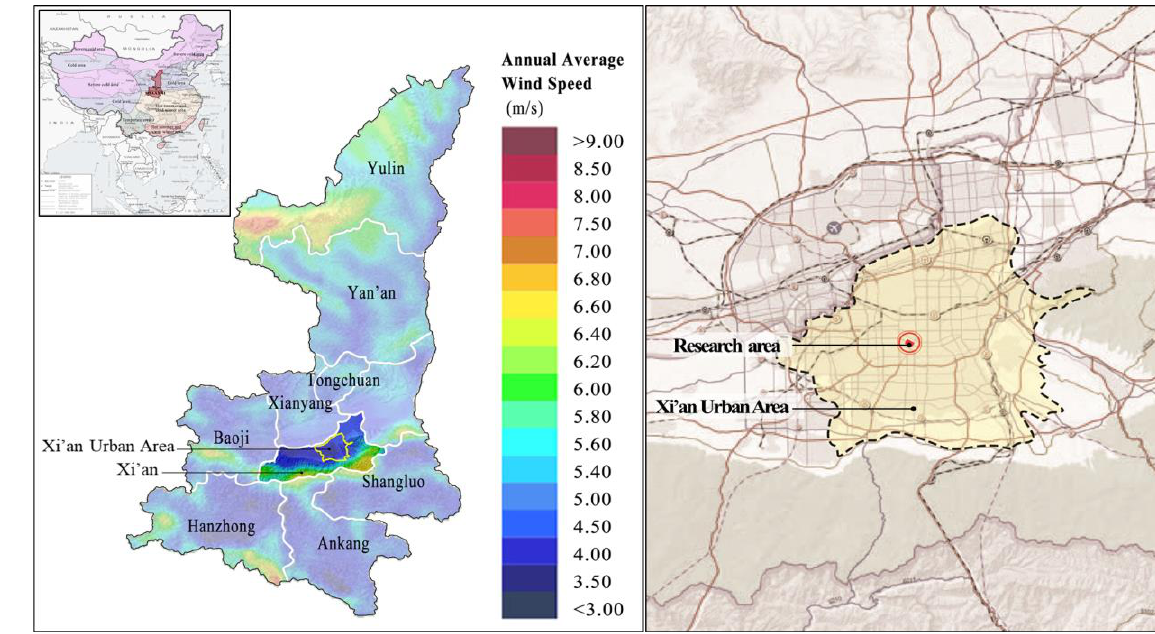
Figure 1. The locations of Xi’an, China.